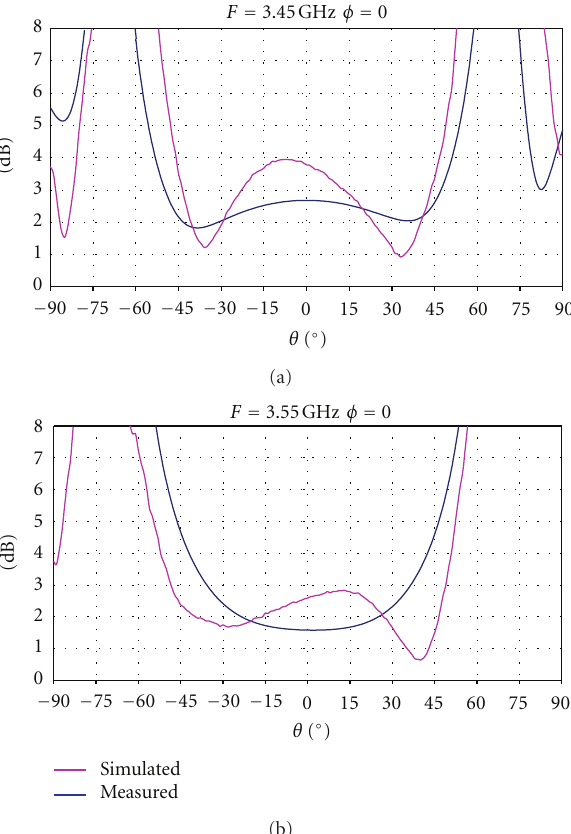
Figure 16: Comparison of AR at 3.45 GHz (a) and 3.55 GHz (b). The objective was set in the direction ( θ = 30 ◦ , Ø = 0 ◦